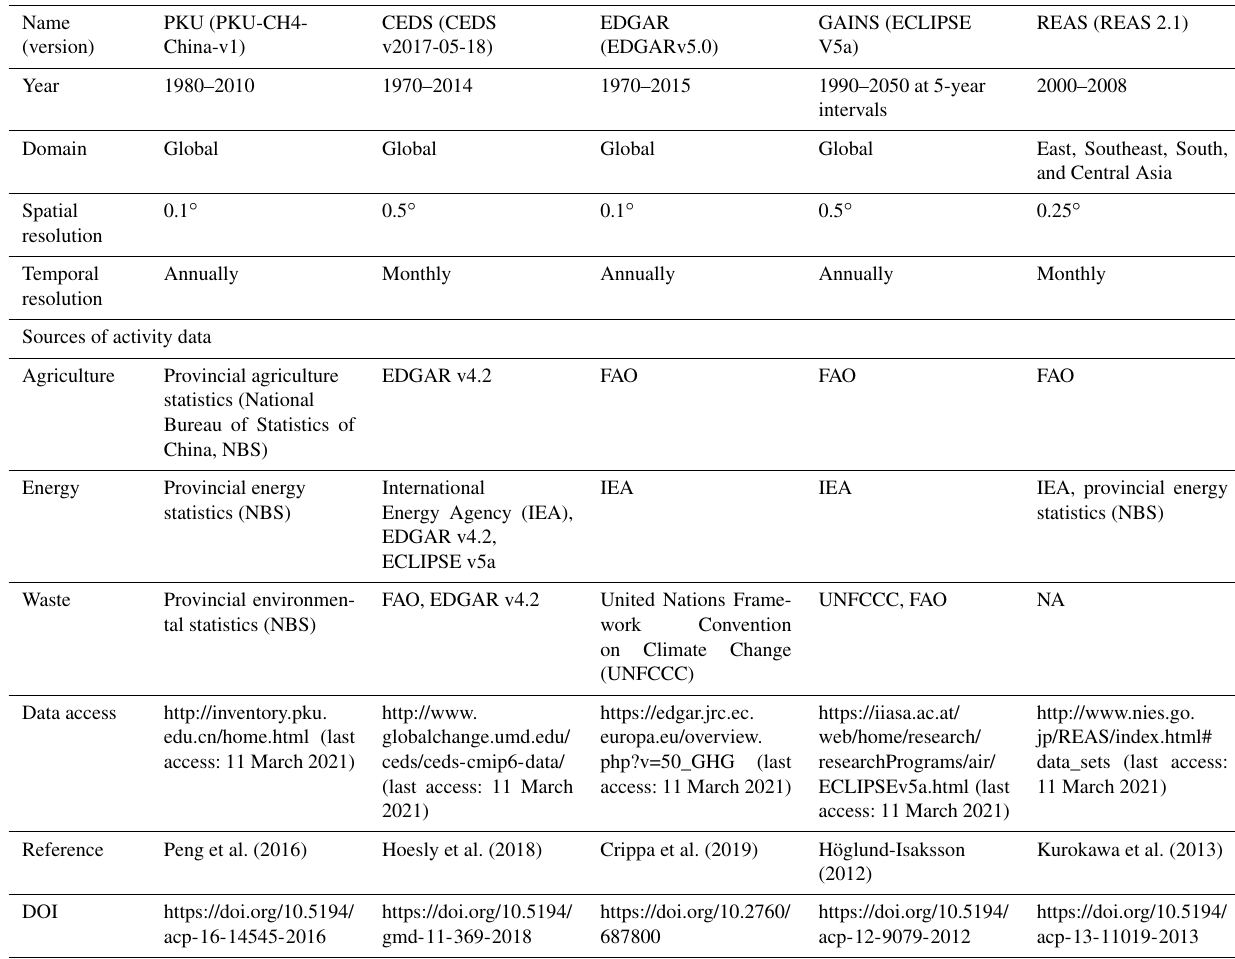
Table 1. Key features of gridded emissions inventories. Name